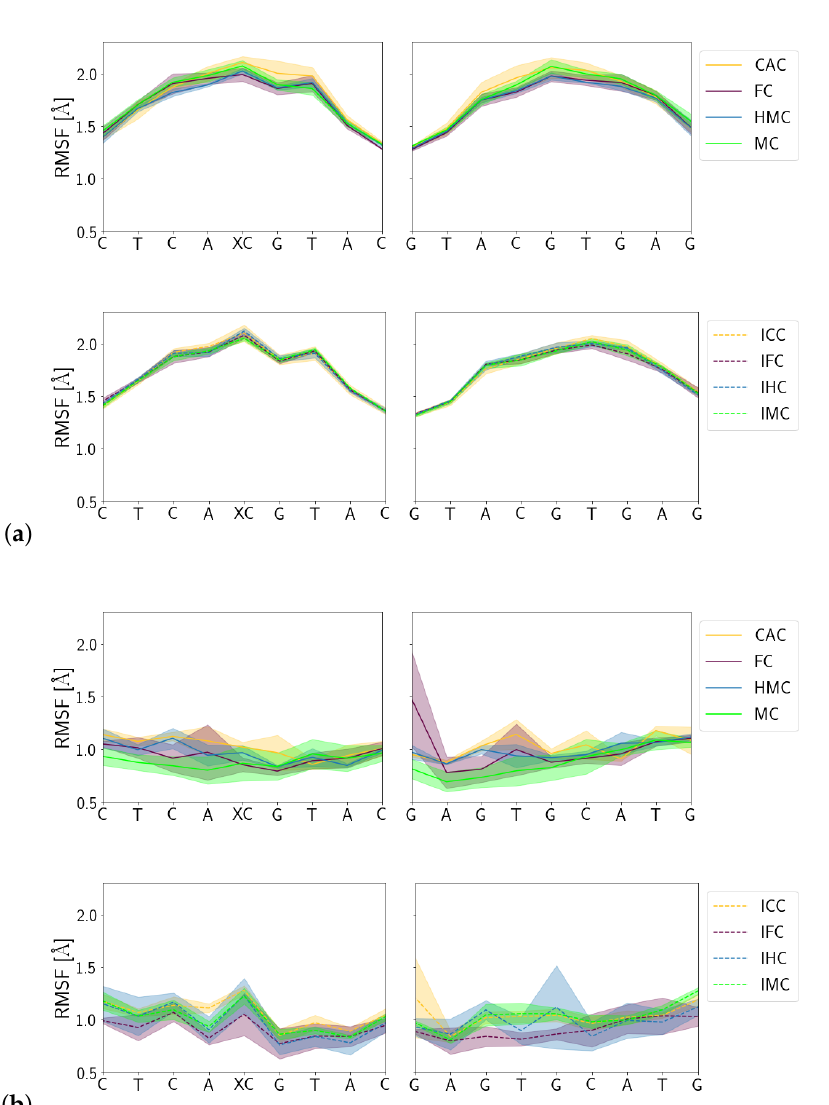
Figure 11. Root mean square fluctuations (RMSF) of ( a ) the free DNA and ( b ) DNA in complex with the TDG